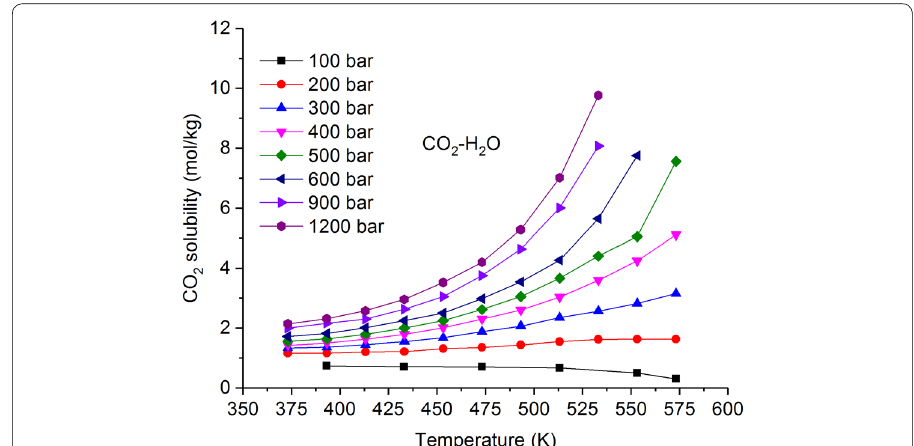
Fig. 9 CO 2 solubility tested by a calibrated Raman system. The data are derived from Guo et al.